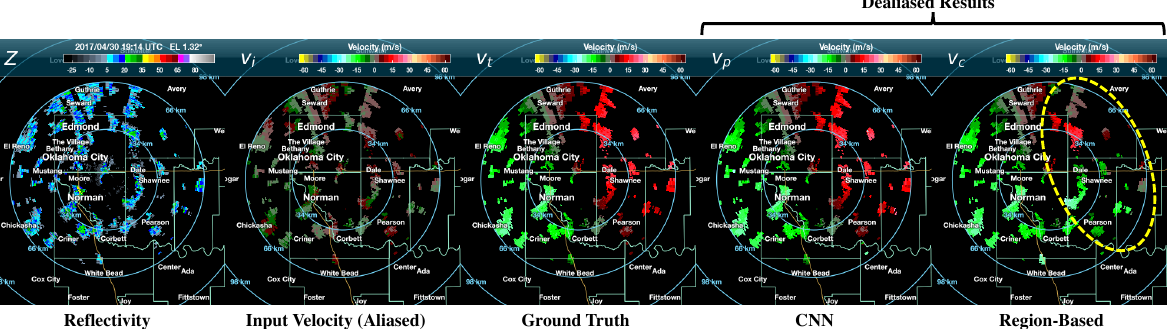
Figure 12. Similar to Figure 11, this figure shows an example PPI scan with isolated storms observed at v a = 7ms − 1 . The data are synthesized using a 1.32 ◦ -EL scan from the KTLX on 30 April 2017 19:14 UTC. The CNN method successfully dealiased the scan as it processed the entire scan all at once. The region-based method, however, failed at a number of isolated storms, which are indicated in the yellow circle. In this example, CNN method predicts the 99.5% on L 0 , 99.4% on L 1 , and 100% on L 2 , while the region-based method predicts 77.9%, 67.8%, and 84.4% on L 0 , L 1 , and L 2 for